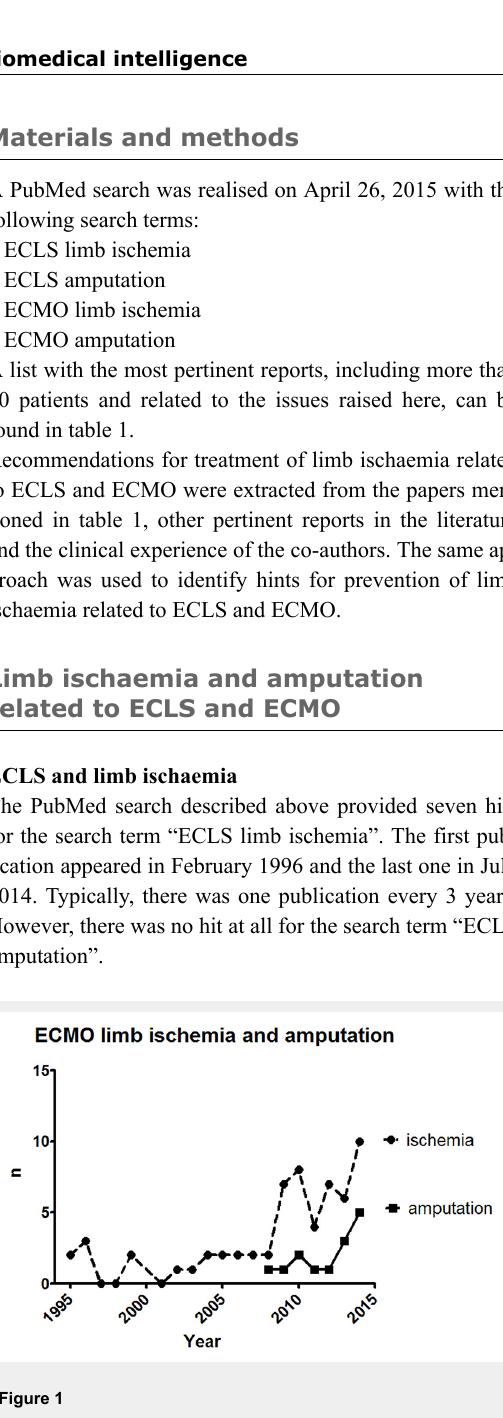
Table 1: Key references including more than twenty patients drawn from Pub Med for lower extremity ischaemia in veno-arterial extracorporeal membrane oxygenation (ECMO) with peripheral cannulation. Ref. no.